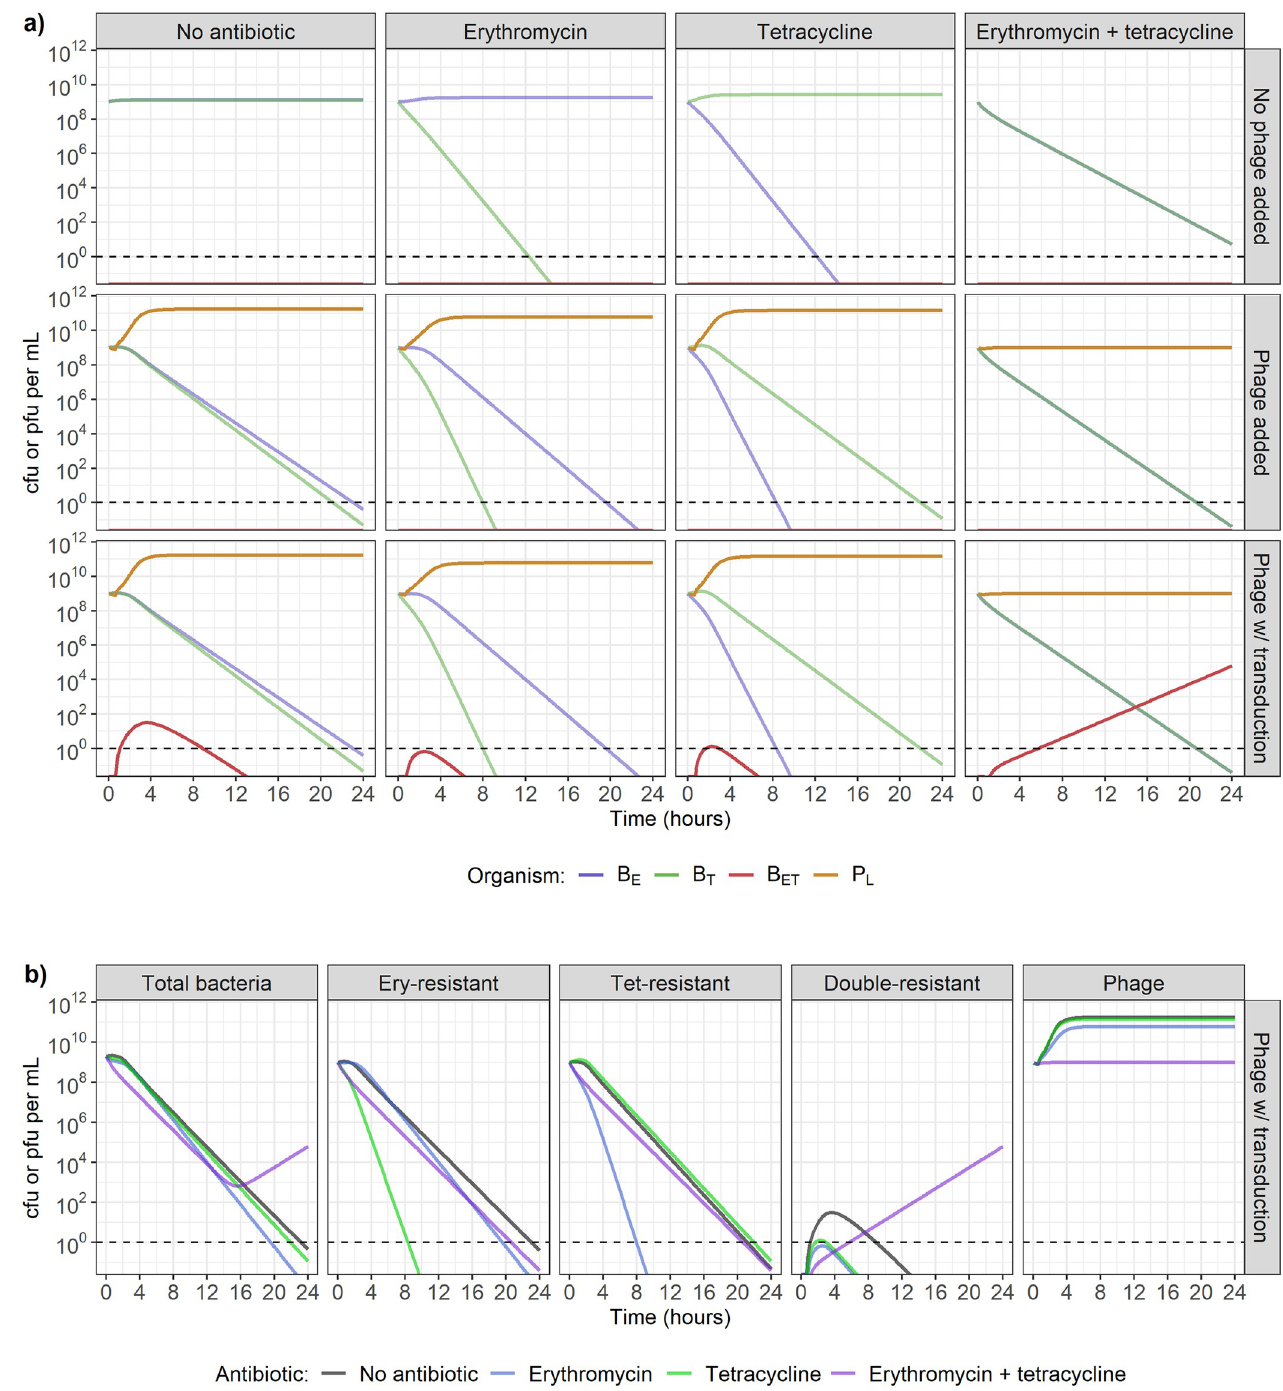
Fig 3. a) Model-predicted dynamics with two single-resistant strains starting at carrying capacity (10 9 colony-forming units (cfu)/mL), in the presence of no antibiotics (1st column), erythromycin only (2nd column), tetracycline only (3rd column), or both erythromycin and tetracycline (4th column), combined with either no phage (top row), phage incapable of transduction (middle row), or phage capable of generalised transduction (bottom row). The starting strains are either erythromycin-resistant (B E ) or tetracycline-resistant (B T ). Antibiotics and/or phage (P L ) are present at the start of the simulation, at concentrations of 1 mg/L (4 x MIC for susceptible strains) and 10 9 plaque-forming units (pfu)/mL respectively. Double-resistant bacteria (B ET ) can be initially generated by generalised transduction only, and then by replication of existing B ET . Dashed line indicates the detection threshold of 1 cfu or pfu/mL. b) Change in bacteria (single-resistant to erythromycin, single-resistant to tetracycline, or double-resistant) and phage numbers depending on the antibiotic exposure, in the presence of phage capable of generalised transduction. Dashed line indicates the detection threshold of 1 cfu or